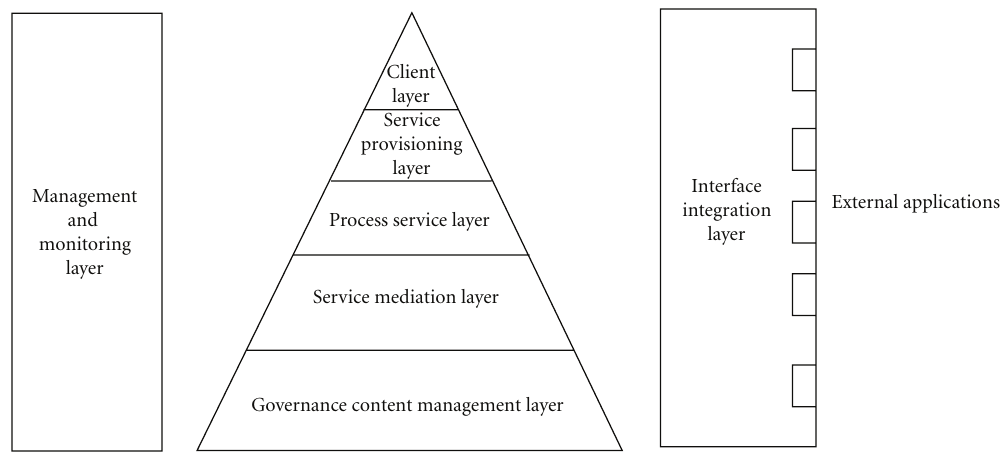
Figure 2: Typical e-governance application